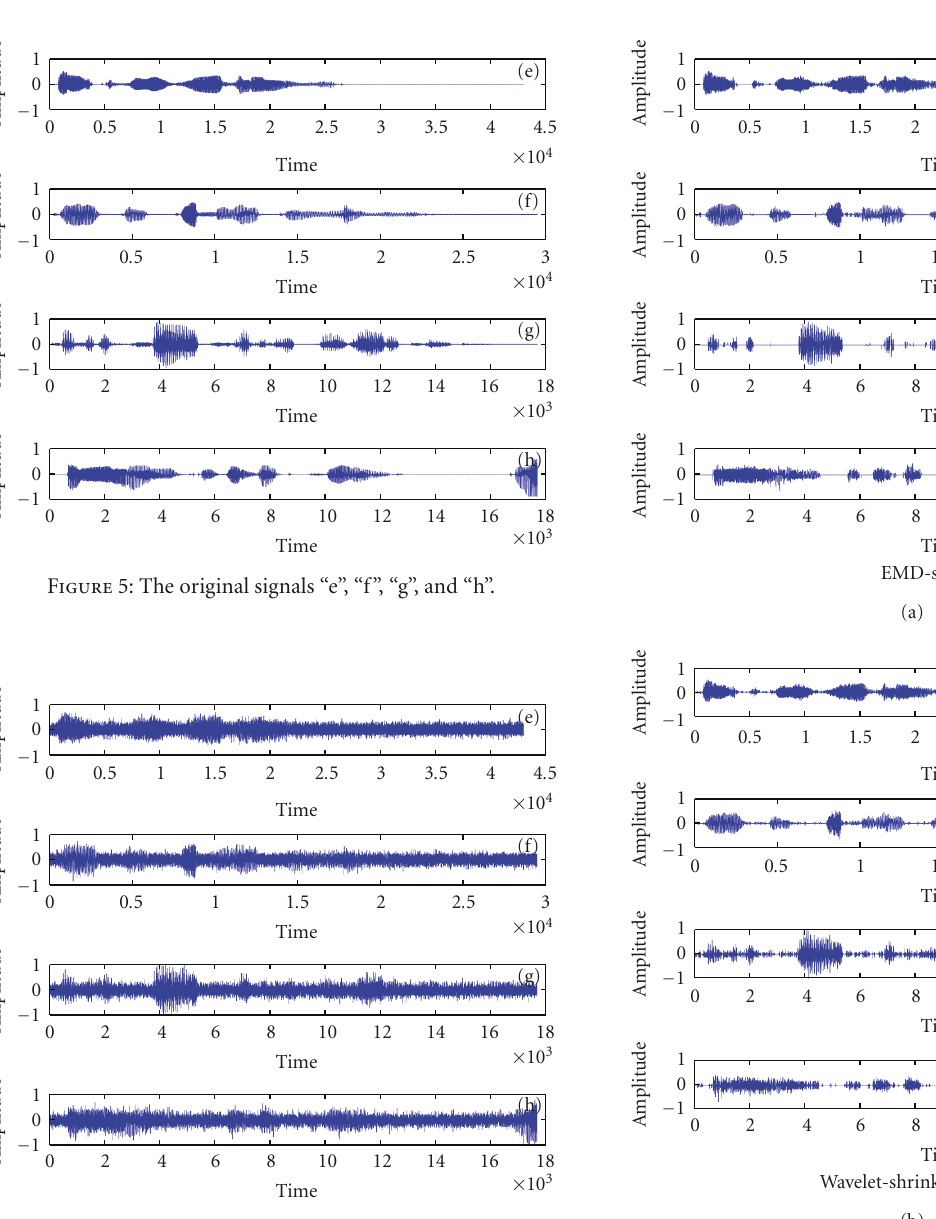
Figure 6: The noisy version of signals “e”, “f”, “g”, and “h” (SNR = − 1 dB).